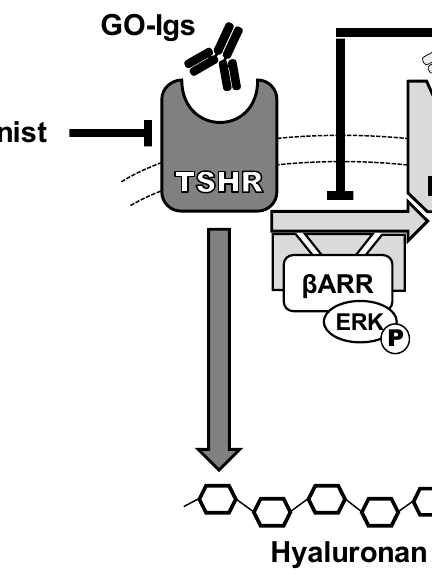
Figure 5. Model of the e ff ects of IGF1R and TSHR antagonists on GO- immunoglobulin (Ig) stimulation of hyaluronan secretion by Graves’ orbital fibroblasts. GO-Igs bind directly to and activate TSHR, stimulating two signaling pathways: IGF1R-independent (dark gray arrow) and IGF1R-dependent (light gray arrows), leading to secretion of hyaluronan. TSHR / IGF1R crosstalk is initiated by binding of GO-Igs to TSHR and requires TSHR and IGF1R to be in close proximity within a signalosome. Synergistic interactions between TSHR and IGF1R occur rapidly at phosphorylation of ERK, demonstrating that crosstalk between TSHR and IGF1R occurs early in the signaling cascade, proximal to the receptors [30]. β -arrestin 1 ( β ARR) is essential for GO-Ig stimulation of ERK phosphorylation, and hyaluronan secretion and proximity ligation assays in GOFs demonstrated that β -arrestin 1 physically sca ff olds TSHRs and IGF1Rs in a protein complex [35]. These pathways appear not to involve cAMP, which has been considered a canonical pathway of TSHR in thyrocytes. However, recent evidence has demonstrated β -arrestin-mediated signaling in thyrocytes and osteoblast-like cells also. Some inhibitory IGF1R antibodies (IGF1RAb), such as 1H7 and probably teprotumumab, bind to IGF1Rs and inhibit activation of IGF1R by activated TSHR via crosstalk. TSHR antagonists, including drug-like small molecule inhibitors, anti-TSHR antibodies and cyclic peptides via immune hyposensitization inhibit signaling initiated by GO-Ig activation of TSHR, and thereby totally abolish both pathways of stimulation of hyaluronan secretion. Combination therapy with TSHR and IGF1R antagonists could minimize drug side e ff ects and, therefore, may have therapeutic benefits [46] .